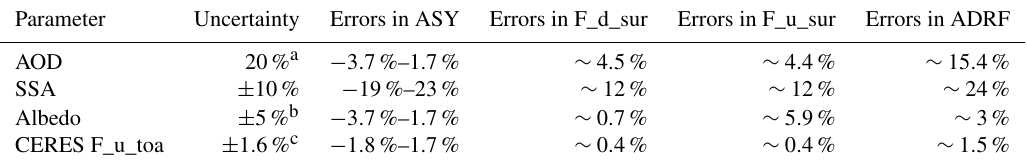
Table 3. Errors induced by different input parameters in ASY, radiative flux (F_d_sur, F_u_sur), and ADRF. Here, the uncertainties of input parameters (AOD, albedo, CERES F_u_toa) are from literatures and the uncertainty of SSA is from validation in Sect. 4. Parameter Uncertainty Errors in ASY Errors in F_d_sur Errors in F_u_sur Errors in ADRF AOD 20% a − 3 . 7%–1.7% ∼ 4 . 5% ∼ 4 . 4% ∼ 15 . 4% SSA ± 10% − 19%–23% ∼ 12% ∼ 12% ∼ 24% Albedo ± 5% b − 3 . 7%–1.7% ∼ 0 . 7% ∼ 5 . 9% ∼ 3% CERES F_u_toa ± 1 . 6% c ∼ 0 .